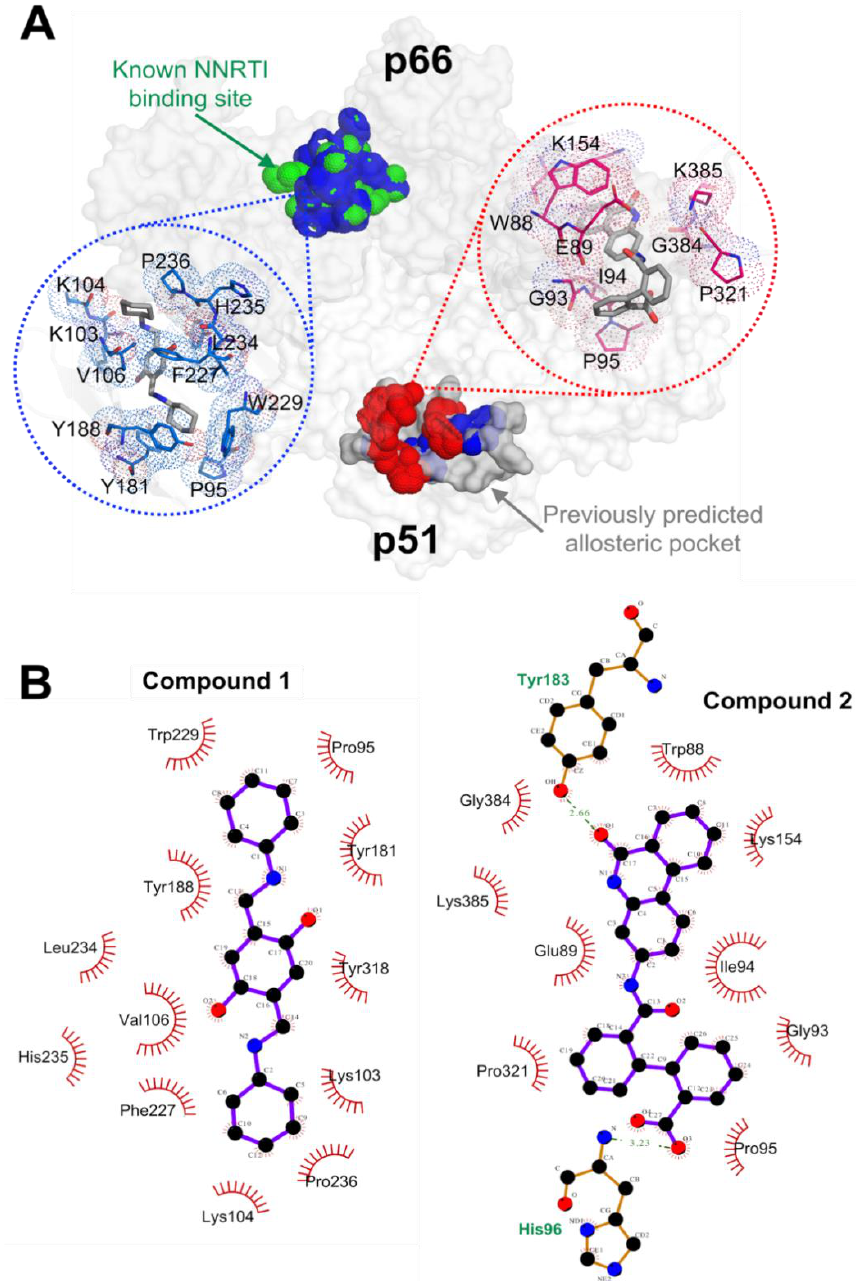
Figure 2. Structural analyses of HIV-1 RT interaction with the two inhibitory compounds. ( A ) Binding sites of compound 1 (blue surface and lines) and compound 2 (red surface and lines) on HIV-1 RT. One of the two binding sites for compound 1 overlaps with the known non-nucleoside reverse transcriptase inhibitor (NNRTI) binding pocket (green, on p66), whereas the other overlaps with our previously predicted allosteric pocket [28] (grey surface on p51), at which compound 2 was also found to bind (red). The two chemical compounds are presented in grey sticks within the binding pockets. ( B ) Two-dimensional (2D) presentation of the interactions between the compounds and their binding sites, constructed using LigPlot +